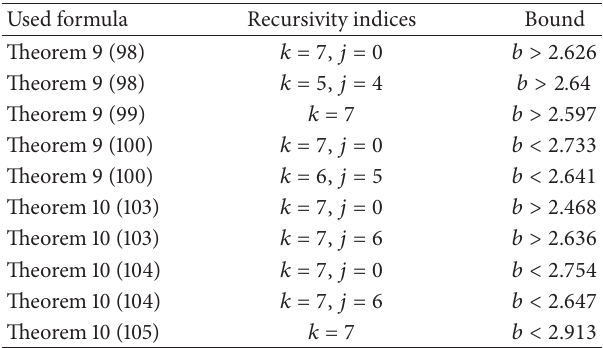
Table 2: Comparison of bounds for 𝑏 in Example